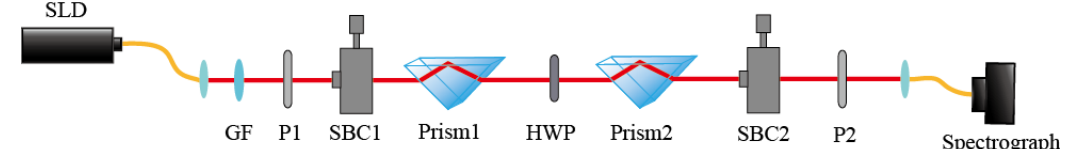
Figure 3. System structure diagram for verifying the differential feasibility test of the weak measurement system.